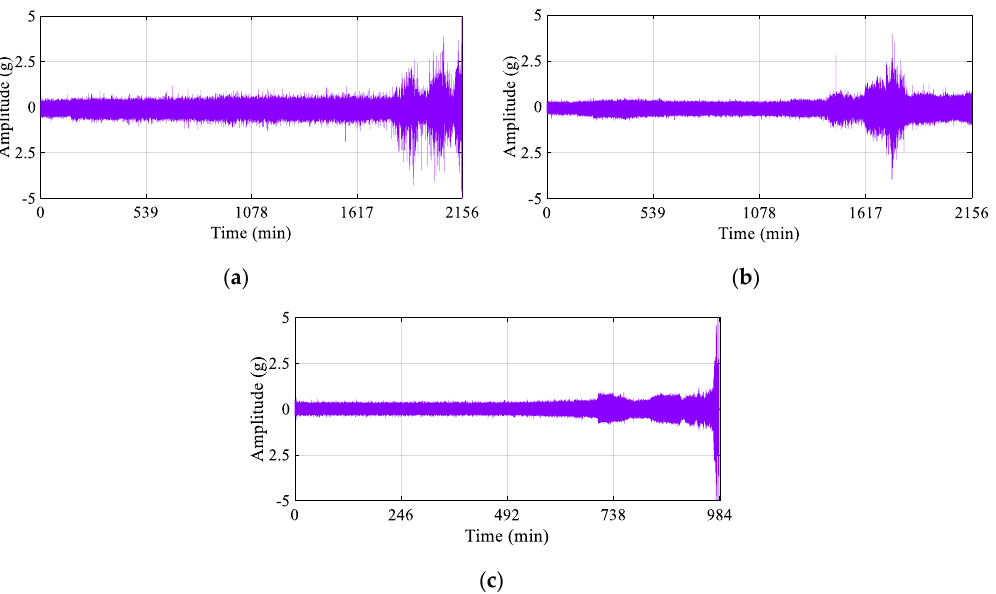
Figure 7. Experimental bearing full life vibration signal: ( a ) Bearing 1, ( b ) Bearing 2, and ( c ) Bearing 3.